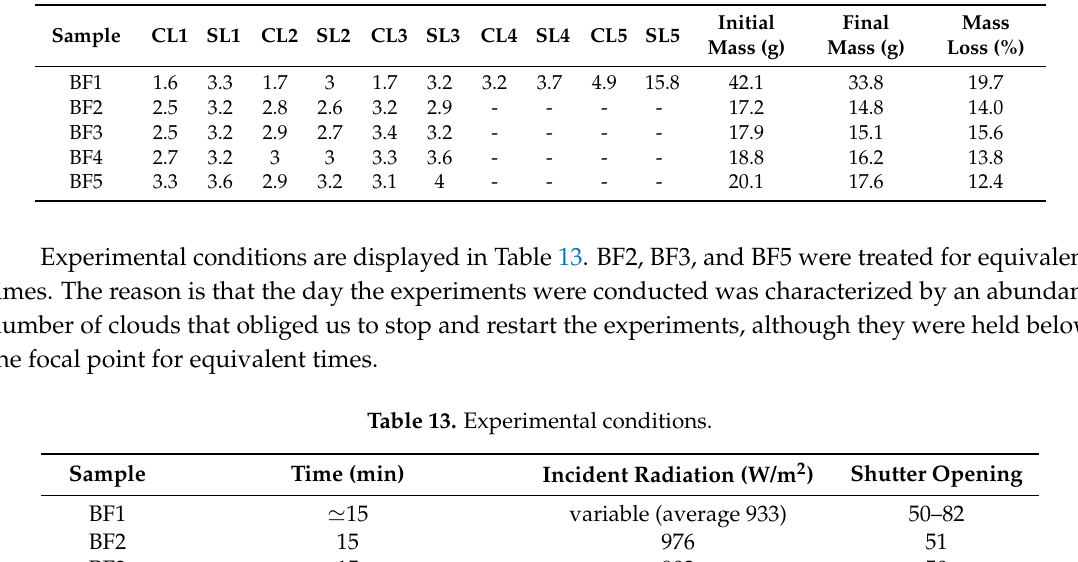
Table 12. Masses of reagents involved in the experiments (CL, mass of the Coke Layer in grams; SL, mass of the Sinter Layer in grams).